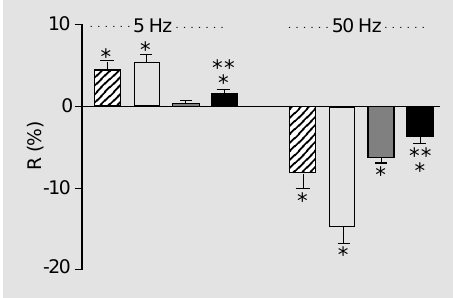
Figure 2. Percentage of increase and reduction in R values in- duced by S-nitroso-N-acetylpeni- cillamine (SNAP, 200 µM), L-ar- ginine (L-Arg, 4.7 mM), and su- peroxide dismutase (SOD, 78 U/ ml) in rat neuromuscular prepa- rations indirectly stimulated with 5 Hz (left columns) and 50 Hz (right columns). Black columns represent the effects induced by L-Arg after N G -nitro-L-arginine (L-NOARG, 8.0 mM) addition. On the ordinate, ratio R (see Fig- ure 1) is expressed as a percent- age of that obtained with drug- free Krebs buffer, taken as 100% (t = 0). The abscissa rep- resents frequency values in Hz. Column height represents the mean (± SEM) of 6 to 8 experi- ments. *P<0.05 compared to control; **P<0.05 compared to L-Arg in the absence of L- NOARG (Student t